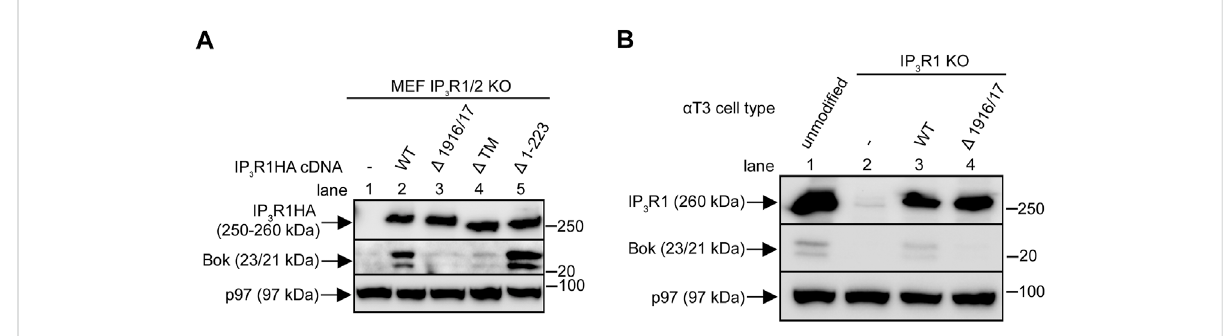
FIGURE 4 Restoration of endogenous Bok expression with exogenous IP 3 R1 constructs. (A) , IP 3 R1/2 KO MEFs were transiently transfected to express IP 3 R1HA constructs and lysates were probed for Bok and IP 3 R1HA constructs with anti-Bok and anti-HA, respectively, with p97 serving as a loading control. (B) , IP 3 R1 KO α T3 cells were transfected to stably express IP 3 R1HA WT or IP 3 R1HA Δ 1916/17 and lysates, together with lysates from unmodi fi ed